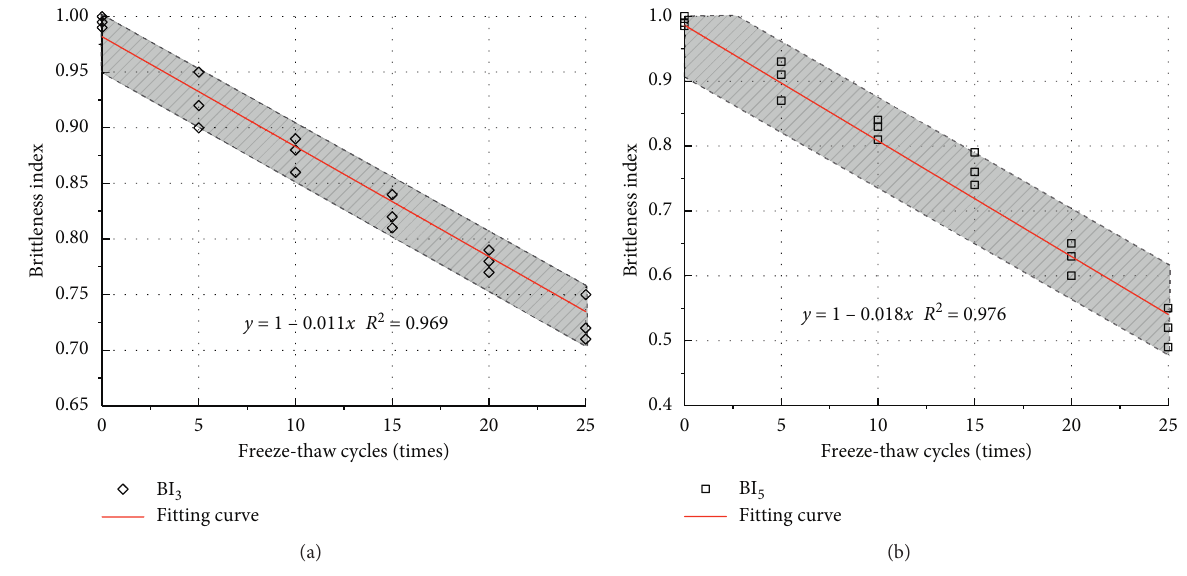
Figure 4: The changes in brittleness parameters of the tested